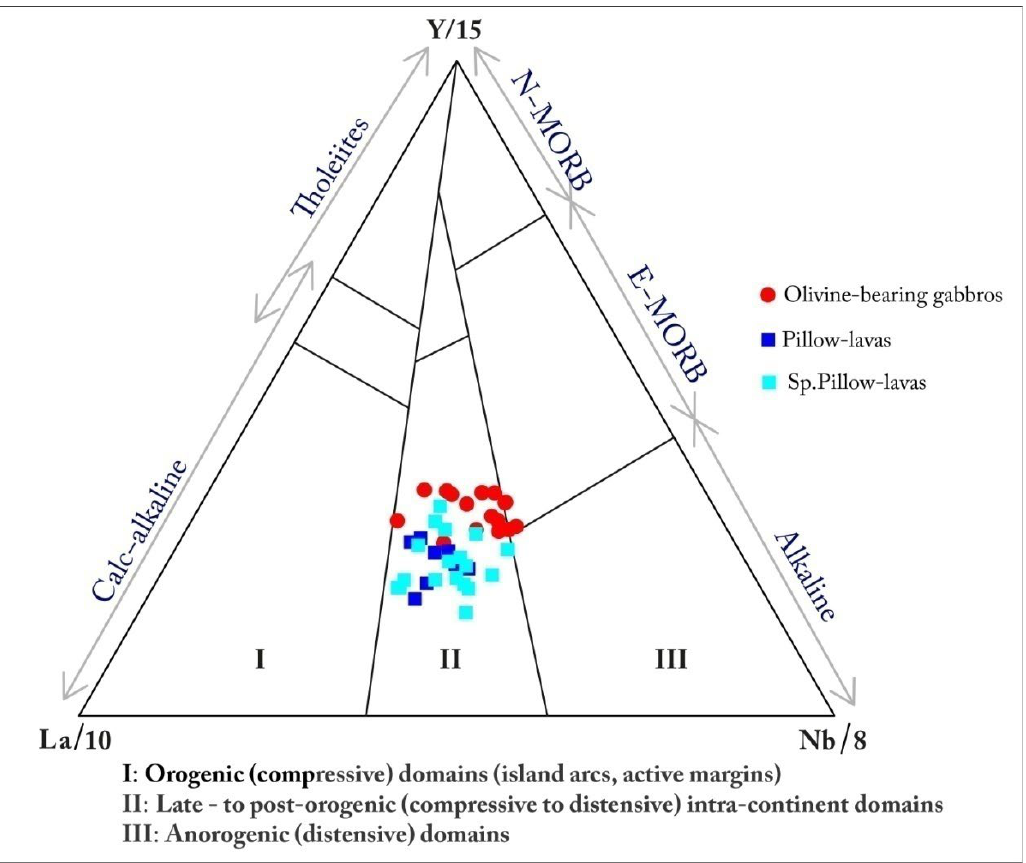
Figure 27. La vs. Y vs. Nb ternary classification diagram [75].